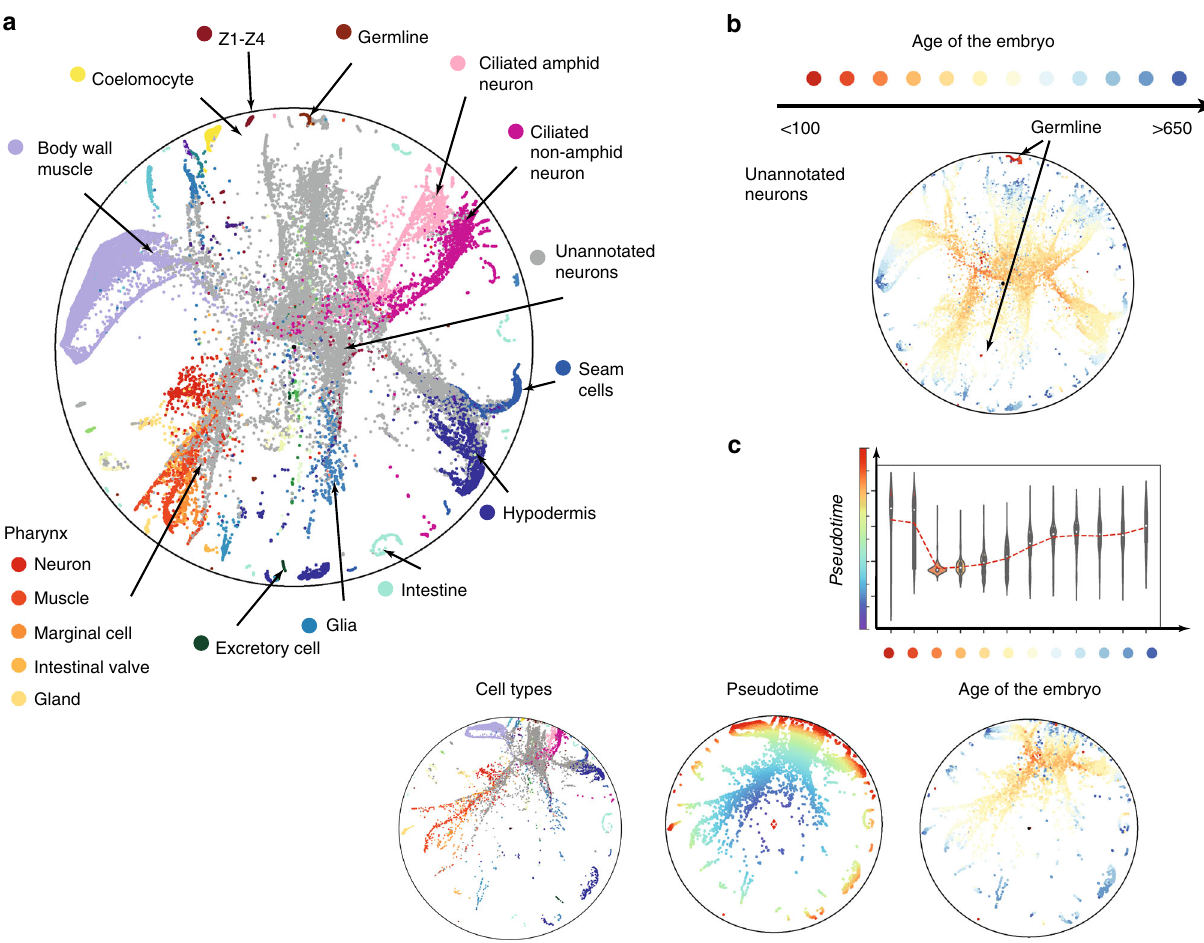
Fig. 3 Analysis of C. elegans cell atlas. a Poincaré map (without rotation) on a 40,000 cell random subsample and 100 PCA components. The parameters used for embedding are ( k = 15, σ = 2.0, γ = 3.0). Main cell types are annotated with a text legend, the rest are separated by color. b Poincaré maps places mature cell types towards the border of the disk. Two subpopulations of germline cells are apparent from the embedding. c Rotation and comparison of Poincaré maps with respect to randomly picked up root cell form one of the sub-populations of the germlines (the one that is more similar to the rest of cell types of the early age the embryo). Red line is an average pseudotime distance for a given age of the